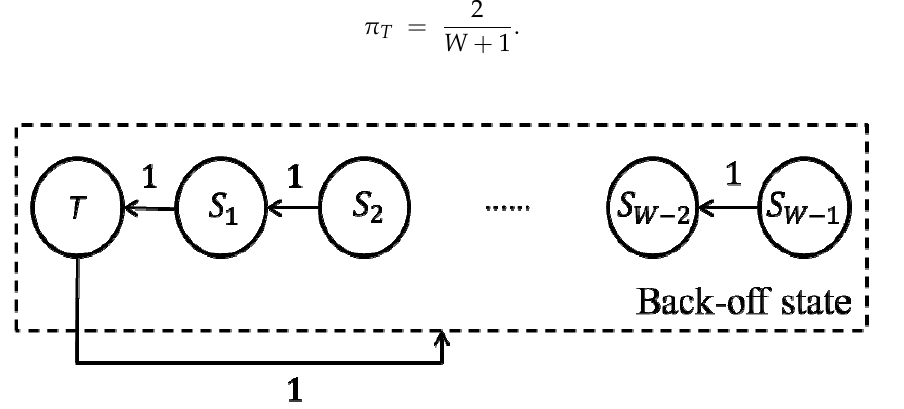
Figure 6. State transition diagram of the HD node in the network.